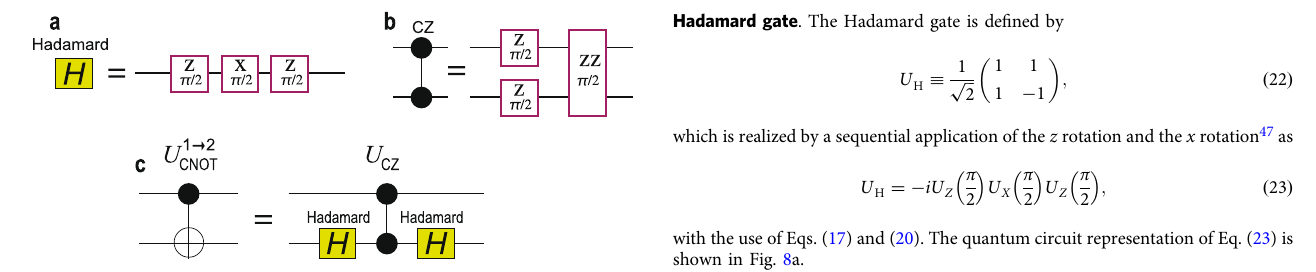
Fig. 8 Quantum circuit representations. a The Hadamard gate in terms of a sequential application of rotation gates as in Eq. (23). b The CZ gate in terms of a sequential application of the z rotation gate and the Ising coupling gate U ZZ as in Eq. (28). c Quantum circuit representations of the equivalence between the CNOT gate as in Eq. (30) and the CZ gate with the application of the Hadamard gates. U 1 ! 2